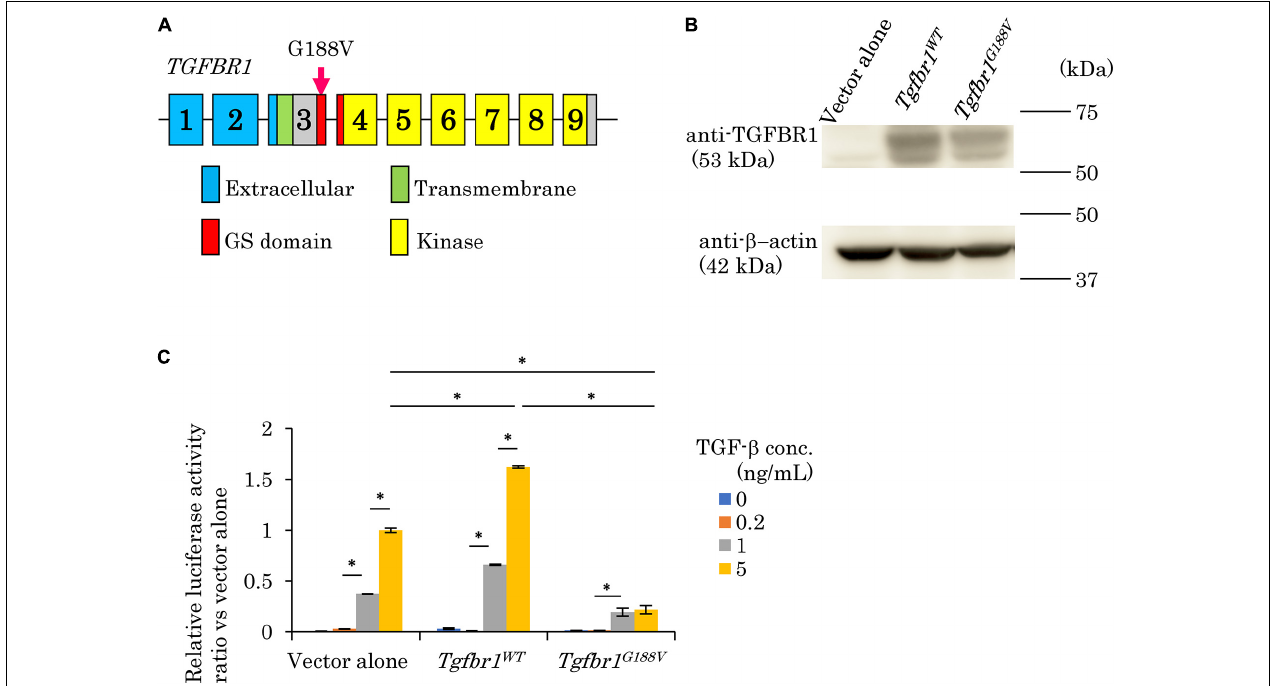
FIGURE 2 | Mutation in exon 3 of TGFBR1 isolated from a patient with LDS and aggressive periodontitis diminishes the response to TGF- β (G188V mutation). (A) Location of the mutation in exon 3 of TGFBR1 . (B) HEK293 cells were transfected with a vector alone, wildtype mouse Tgfbr1 ( Tgfbr1 WT ), or mouse Tgfbr1 with the G188V mutation ( Tgfbr1 G 188 V ). Lysates of transfected cells were subjected to western blot analysis using an anti-TGFBR1 antibody. (C) TGF- β -induced promoter activity was assessed by the dual luciferase reporter assay system. Values represent the mean ± SD in triplicate assays. ∗ P < 0.05, compared with the indicated TGF- β